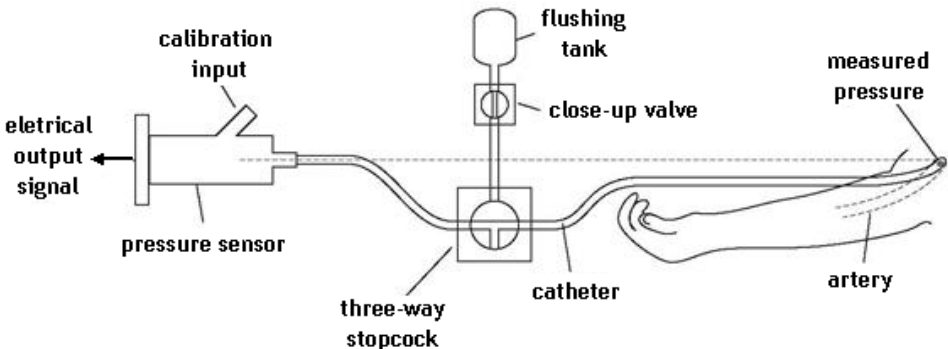
Figure 1. Invasive blood pressure measurement with a fluid ‐ filled catheter [6].